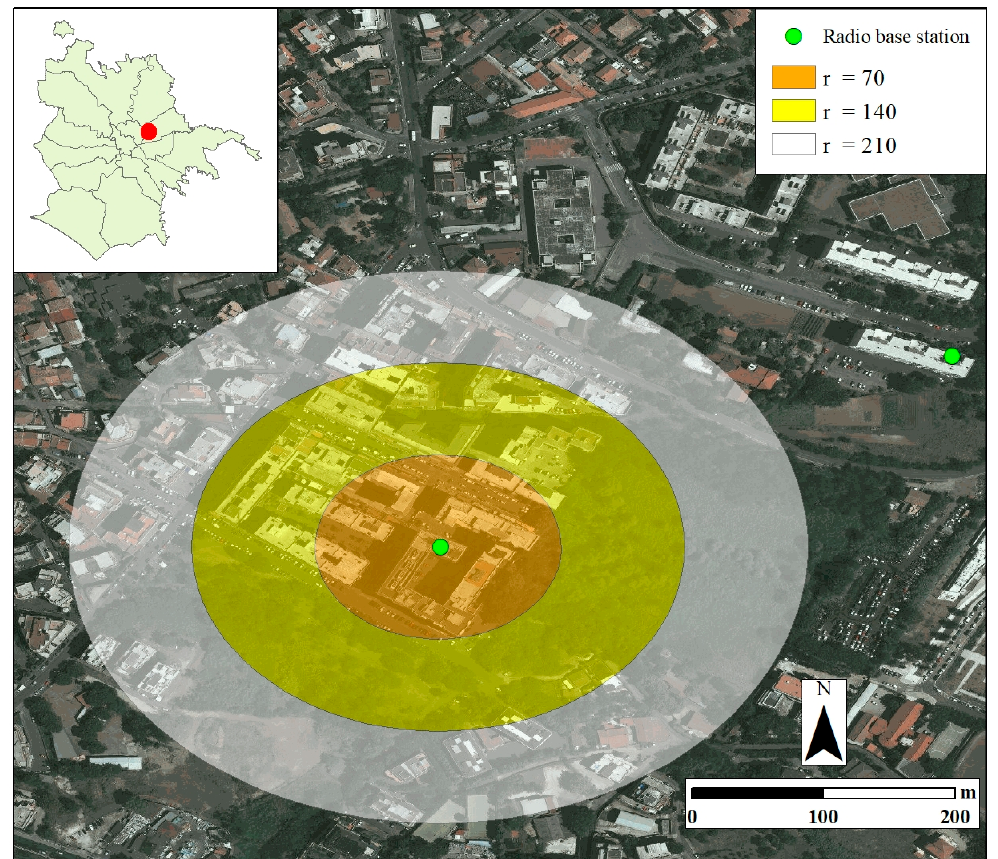
Figure 5. Circular buffer zones (in meters) defined by the imposing high antenna (the same as in Figure 4) in a GIS environment. Source: authors’ elaboration.